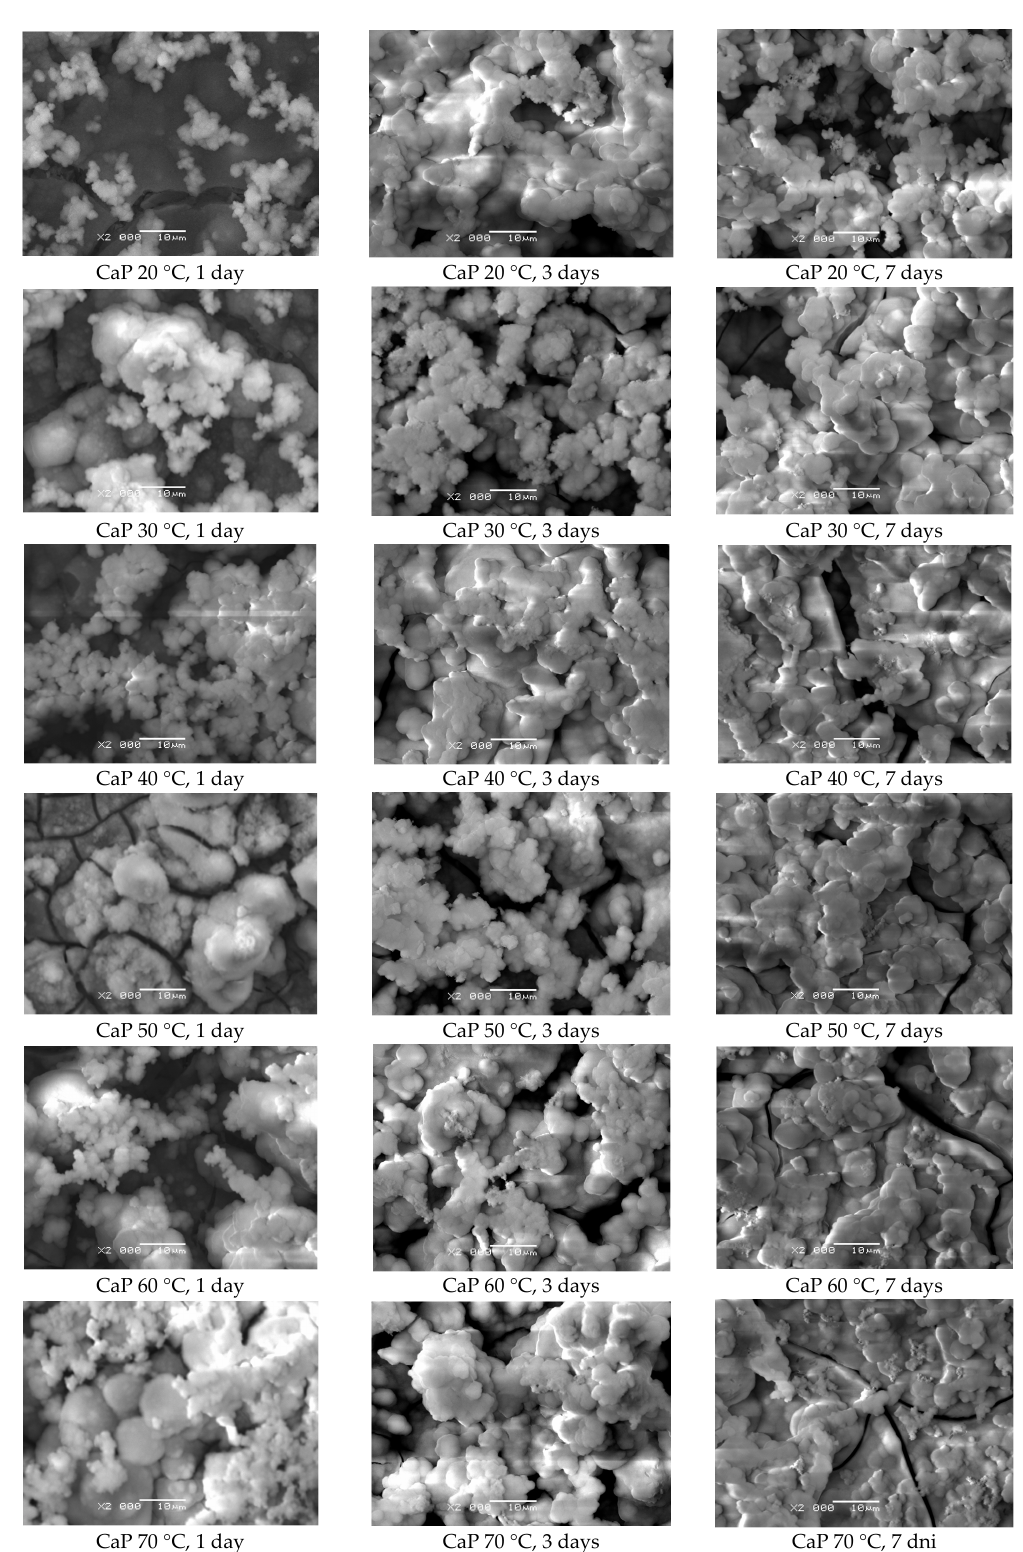
Figure 10. SEM image of the CpTi G4 substrate with CaP coating deposited at − 3 V for 30 min, at 20 to 70 ◦ C, after bioactivity test for 1, 3, and 7 days of immersion in SBF at 36.6 ◦ C ( × 2000